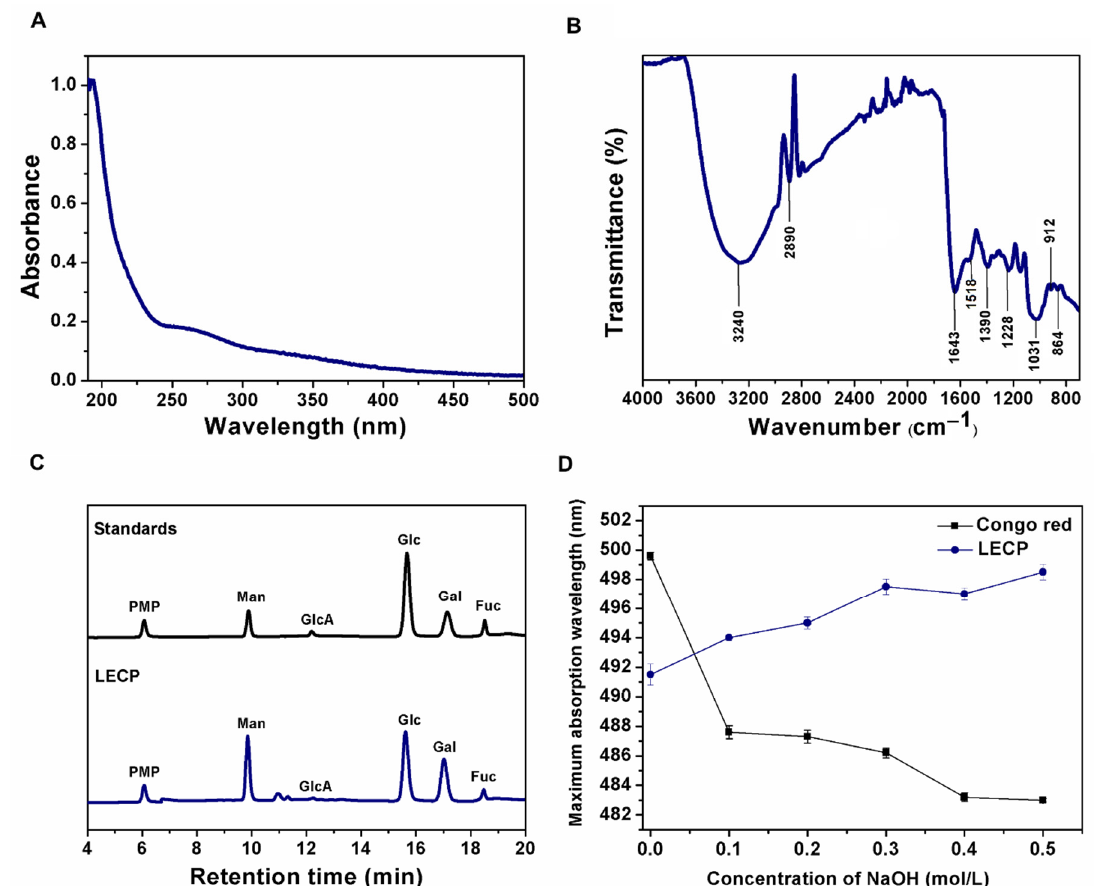
Figure 1. Characterization of LECP: ( A ) UV-Vis spectrum, ( B ) FT-IR spectrum, ( C ) HPLC chroma- togram profile of monosaccharide composition, and ( D ) Changes in maximum absorption wave- length of Congo red (control) and Congo red with the LECP at different concentrations of NaOH. The abbreviations can be found in the Section 2.1.